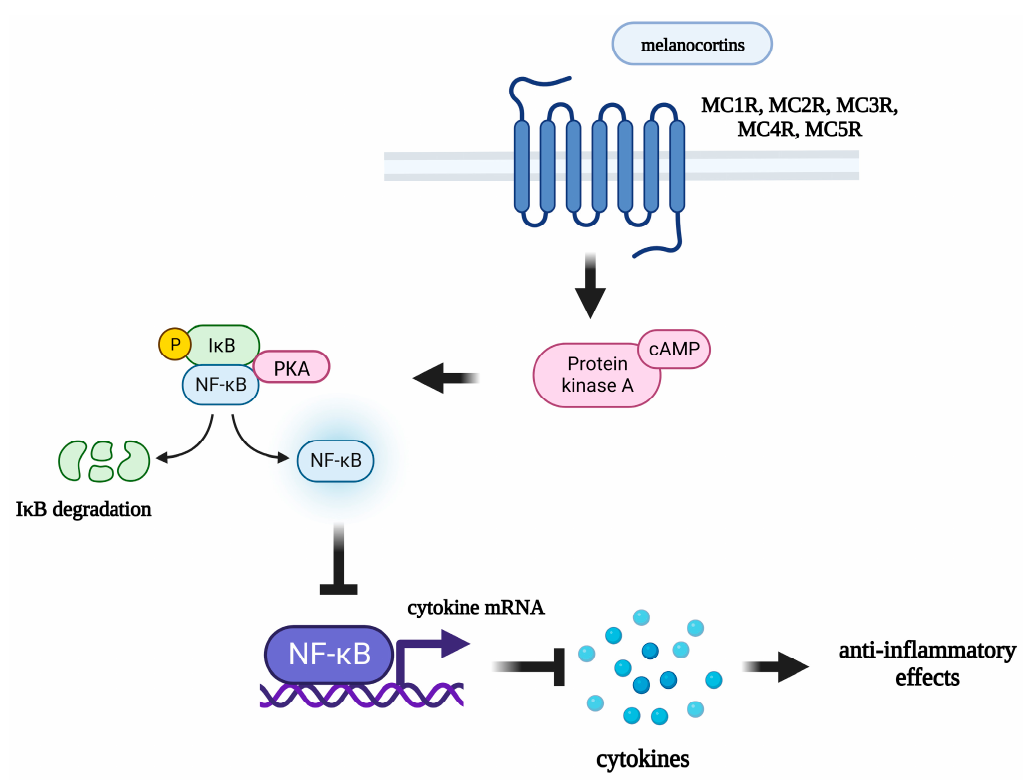
Figure 1. Mechanism of anti-inflammatory effects of melanocortins. MC1R: melanocortin 1 receptor; MC2R: melanocortin 2 receptor; MC3R: melanocortin 3 receptor; MC4R: melanocortin 4 receptor; MC5R: melanocortin 5 receptor; cAMP: cyclic adenosine monophosphate; PKA: protein kinase A; I κ B: inhibitor of nuclear factor kappa B; NF- κ B: nuclear factor kappa-light-chain-enhancer of activated B cells.